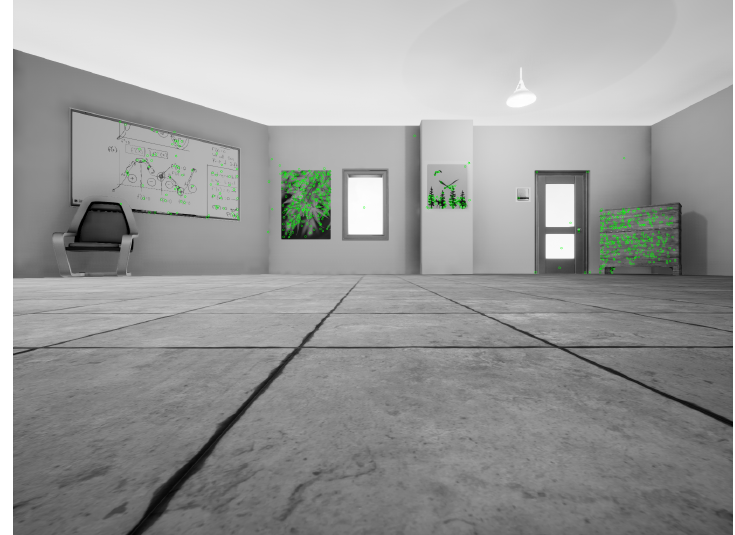
Figure 2. View of an environment with computed features.